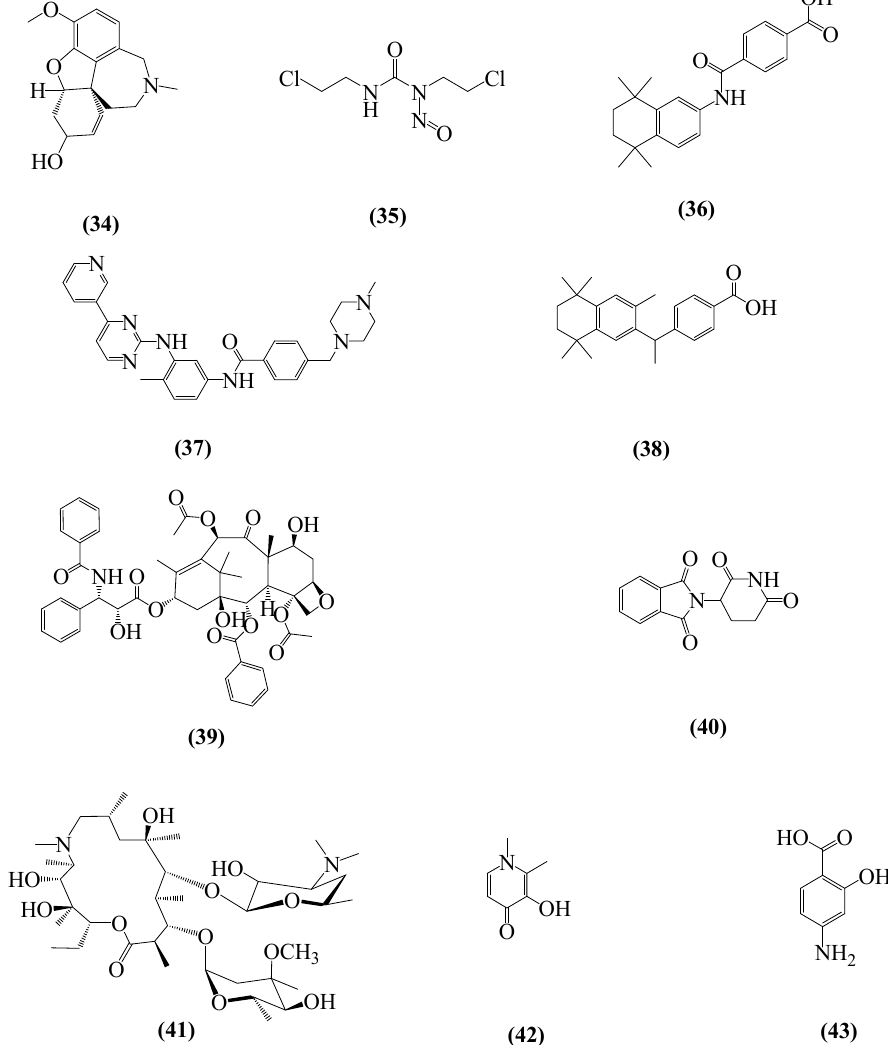
Figure 11. Chemical structures of commercialized drugs proposed for NDD treatment: galantamine, (4aS,6R,8aS)-5,6,9,10,11,12-Hexahydro-3-methoxy-11-methyl-4aH-[1]benzofuro[3a,3,2-ef][2]benzazepin- 6-ol ( 34 ); casmustine ( 35 ), 1,3-Bis(2-chloroethyl)-1-nitrosourea; tamibarotene ( 36 ), 4-[(1,1,4,4- tetramethyltetralin-6-yl)carbamoyl]benzoic acid; imatinib ( 37 ), 4-[(4-methylpiperazin-1-yl)methyl]- N-[4-methyl-3-[(4-pyridin-3-ylpyrimidin-2-yl)amino]phenyl]benzamide; bexarotene ( 38 ), 4-[1-(5,6,7,8- tetrahydro-3,5,5,8,8-pentamethyl-2-naphthalenyl)ethenyl]benzoic acid; paclitaxel ( 39 ), (2 α ,4 α ,5 β ,7 β , 10 β ,13 α